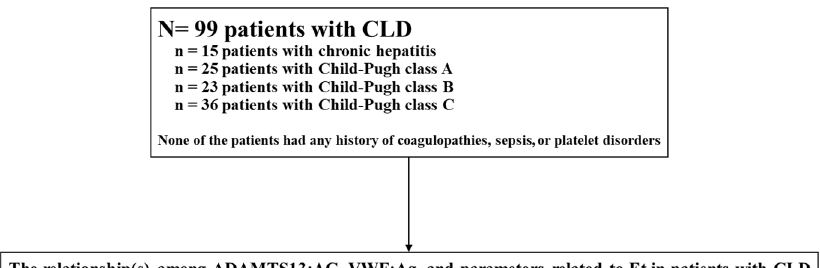
Figure 1. Study design. A total of 99 patients with CLD were included in this study. None of the included patients had any history of coagulopathy, sepsis, or platelet disorders. We investigated the relationship(s) among ADAMTS13:AC, VWF:Ag, and parameters related to Et in patients with CLD to determine the cause of the imbalance between ADAMTS13:AC and VWF:Ag in these patients. CLD, chronic liver diseases; ADAMTS13, a disintegrin-like and metalloproteinase with thrombospondin type 1 motifs 13; ADAMTS13:AC, ADAMTS13 activity; VWF, von Willebrand factor; VWF:Ag, VWF antigen; Et,